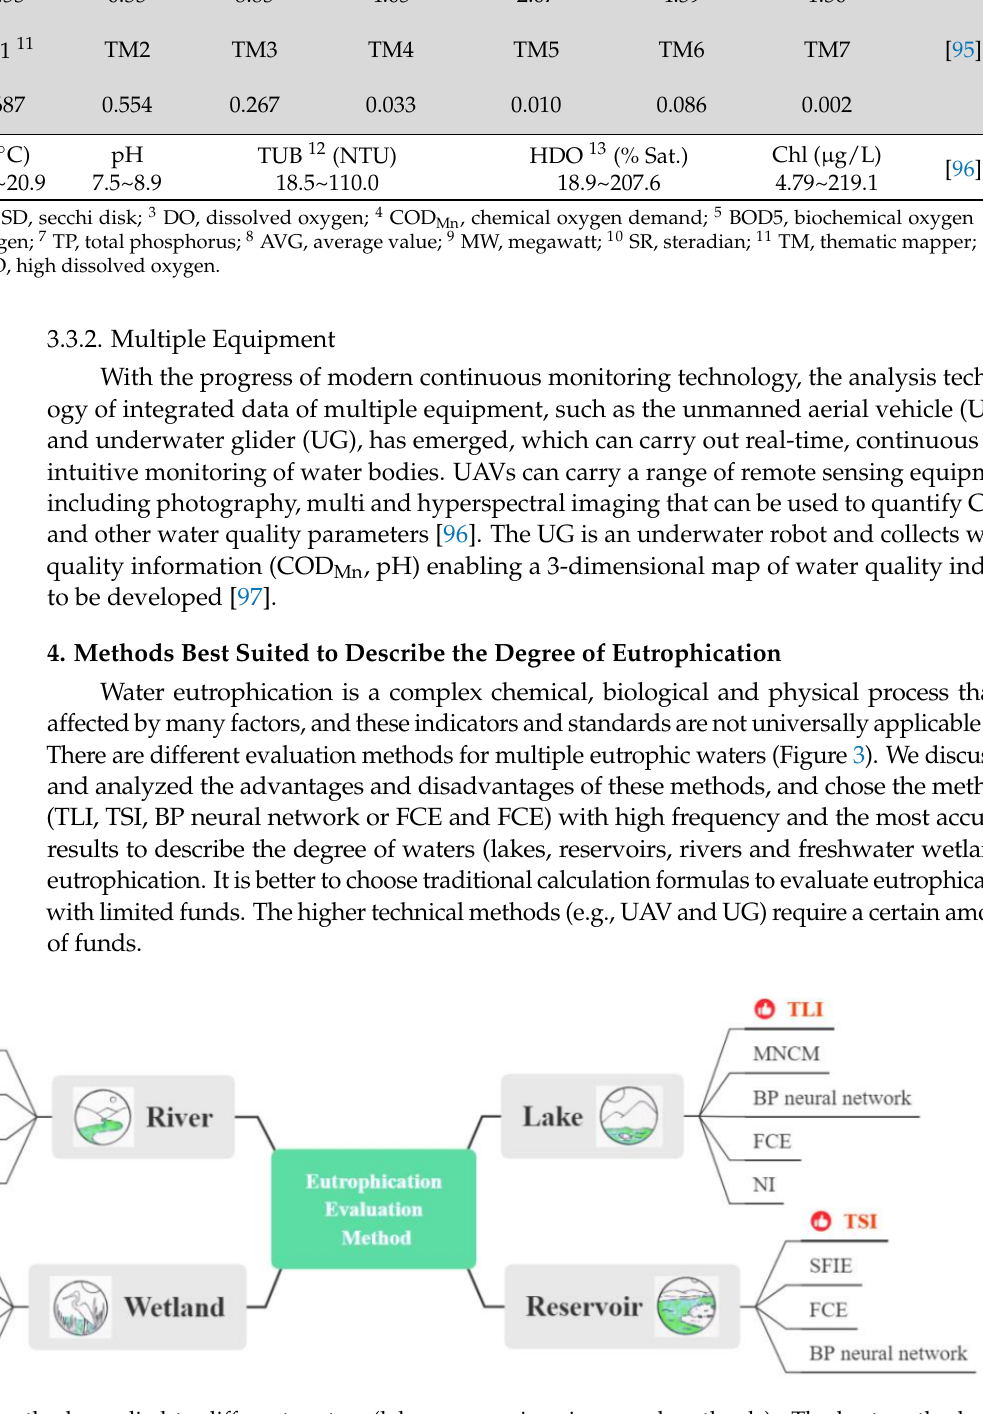
Figure 3. Evaluation methods applied to different waters (lakes, reservoirs, rivers and wetlands). The best methods identified in this work is written in red